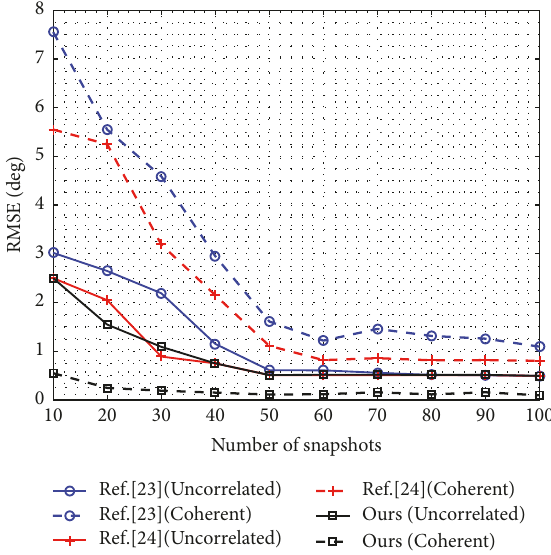
Figure 6: The RMSE of DOA estimation versus SNR. Figure 7: The RMSE of DOA estimation versus the number of